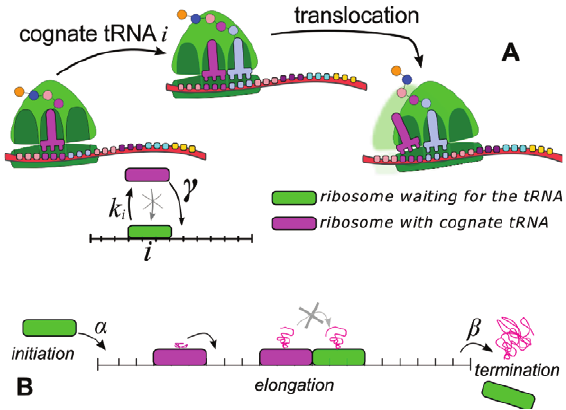
Figure 1. The model. Particles representing ribosomes move along a unidimensional lattice (the mRNA chain) in which each site represents a codon. For the sake of illustration, in the sketch a particle covers 3 codons, while in the model we considered particles occupying 9 codons [15]. ( A ) Schematic representation of ribosome dynamics: along the mRNA, ribosomes with the A site on codon i capture the cognate tRNA with a rate k i , then keep it and advance with a rate c , provided that the following codon is empty. ( B ) The entire translation process can be viewed as particles moving on a lattice. Ribosomes attempt to initiate the translation with a rate a . Then they move according to the dynamical rules introduced above and at the end of the lattice the ribosomes detach with a termination rate b . Particles can queue if the bottlenecks in the lattice cannot support the incoming flow.